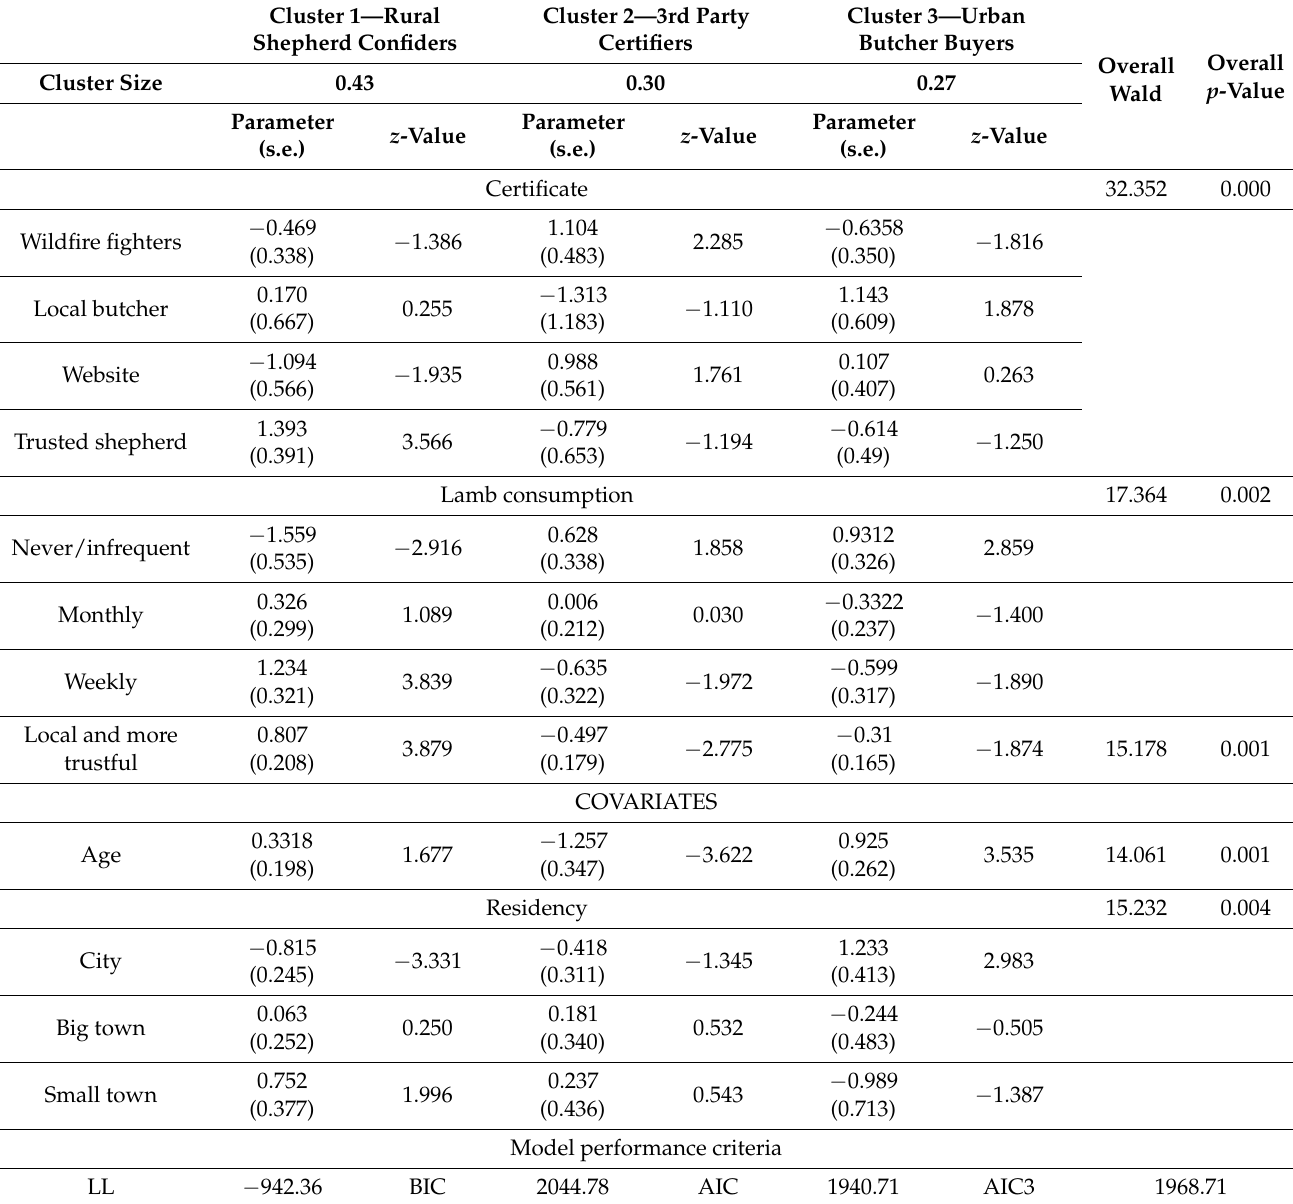
Table 1. Estimates of the latent class model (3